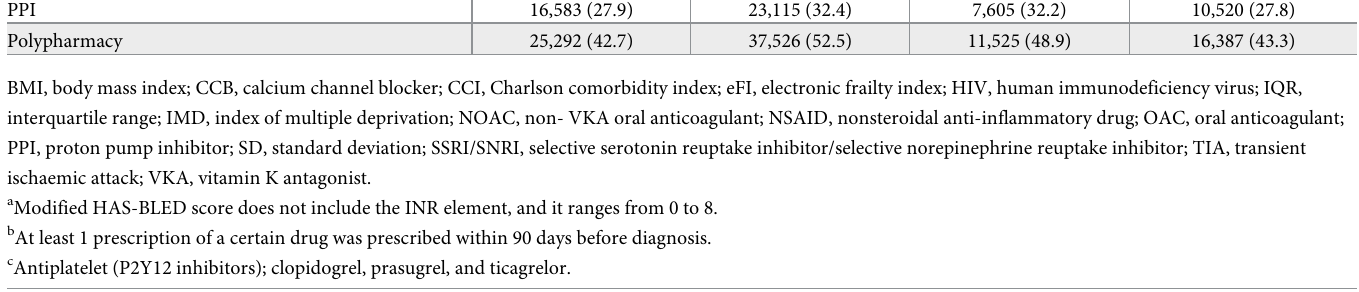
(IMD 5) were at lower risk of being prescribed OAC (RRR 0.85; 95% CI 0.79 to 0.91) and were at higher risk of being prescribed aspirin only (RRR 1.11; 95% CI 1.02 to 1.21) than patients living in the least deprived areas (IMD 1). Compared to white patients, patients from black, and other ethnic minorities were more likely to receive no treatment than OAC (RRR 0.78; 95% CI 0.65 to 0.94, and RRR 0.76; 0.64 to 0.91, respectively). S14 Table provides the